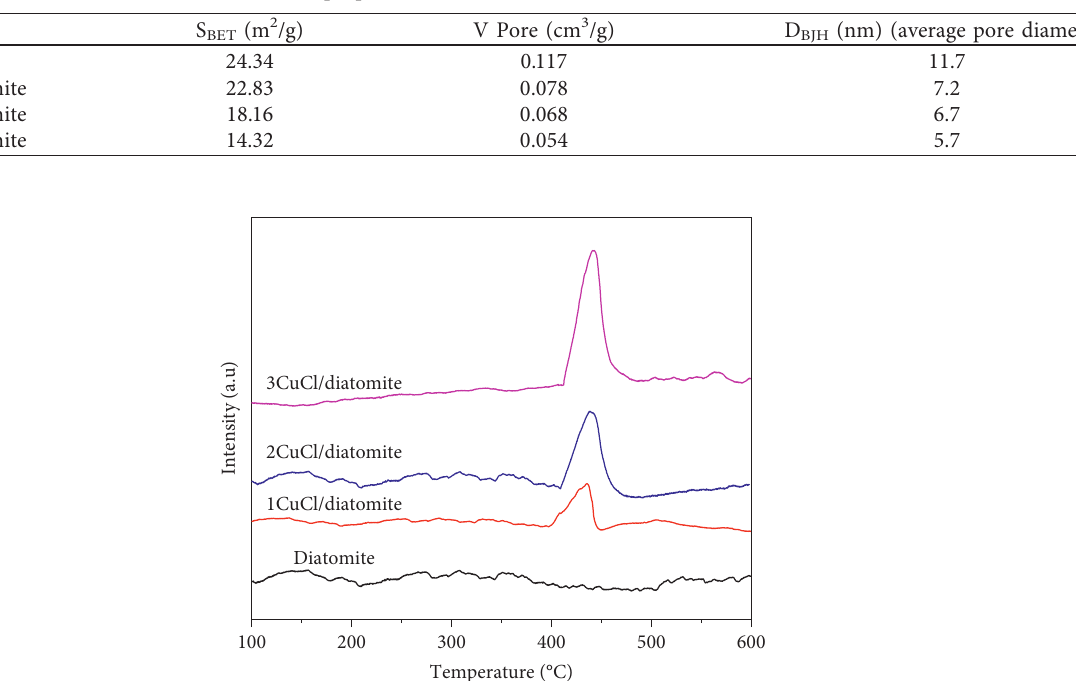
Figure 6: N 2 adsorption-desorption isotherms of diatomite and Table 2: Textural properties of diatomite and CuCl-modified diatomites.